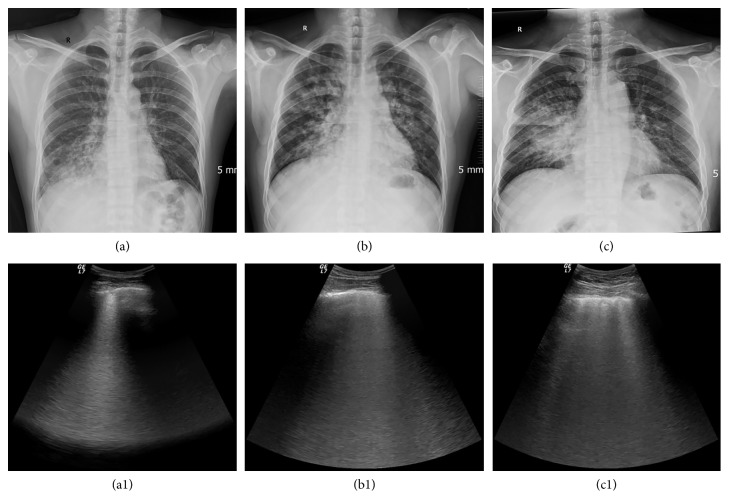
HAPE had multiple manifestations on CXR, whereas the LUS manifestations were only intensive B-lines. (a) Flake and trabs like shadow in inferior lobe of right lung; (a1), corresponding LUS image; (b) butterfly-shaped shadow; (b1), corresponding LUS image; (c) large infiltrates involving the entire lobar; (c1), corresponding LUS image.